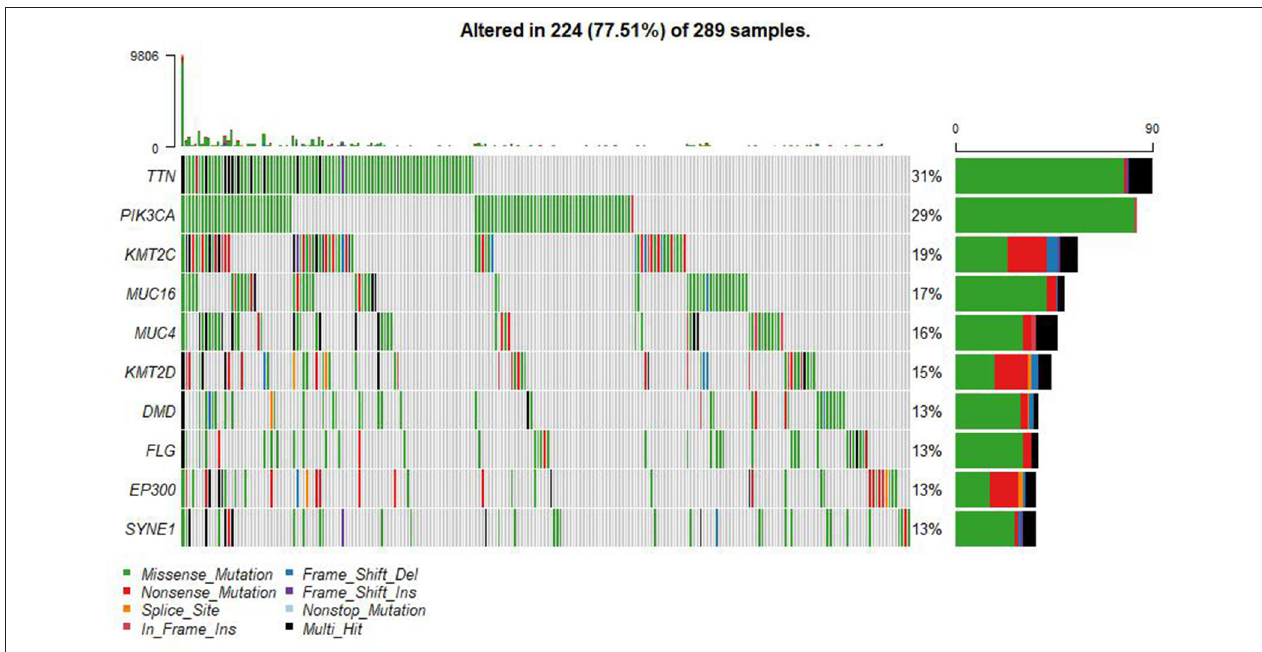
FIGURE 3 | Summary of the TCGA CESC mutations. There were 55,768 mutations in all 289 samples. The top 10 mutant genes were TNN, MUC4, PIK3CA, MUC16, KMT2C, KMT2D, SYNE1, FLG, EP300, and DMD.